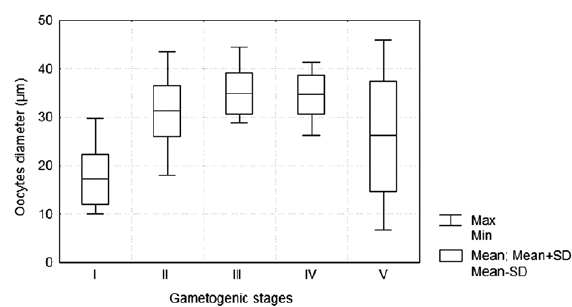
Fig. 6. – Average oocyte diameters relating to each stage of devel- opment of A. tuberculata: I, early active; II, late active; III, ripe; IV, partially spawned; V, spent.